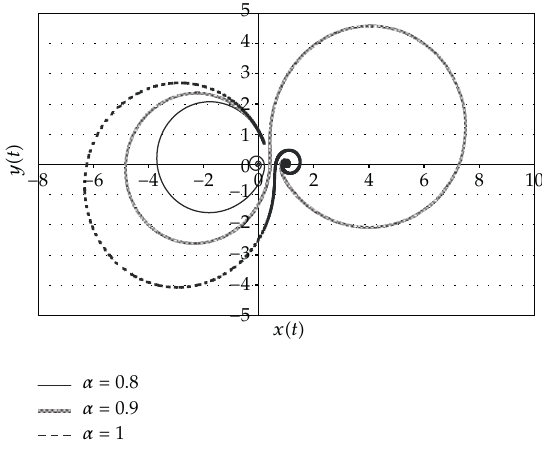
Figure 8: x (cid:2) 0 (cid:3) (cid:6) 0.2, y (cid:2) 0 (cid:3) (cid:6) 0.7, a (cid:6) 0.1, b (cid:6) 0.5.